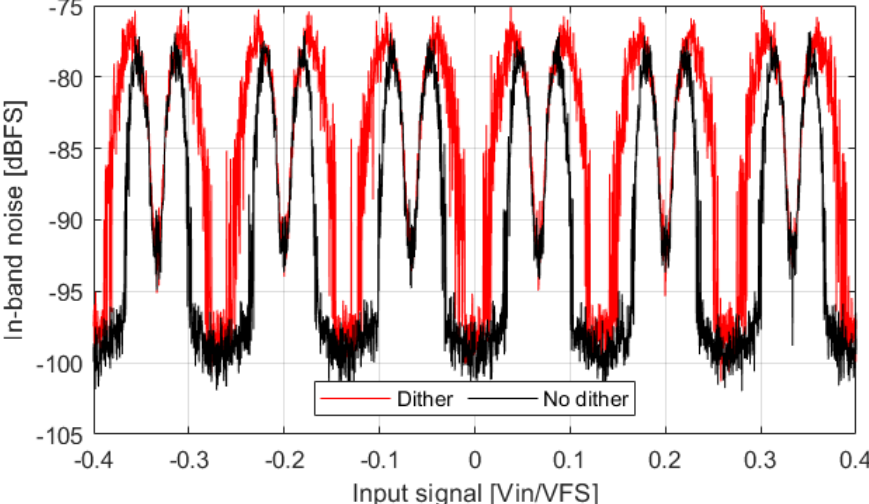
Figure 6. IBN power of a Σ∆ M whose parameters are: third-order, 4-bits, OSR = 32, BW = 20 kHz, OBG = 1.8. Output signal is divided into segments of 3.2